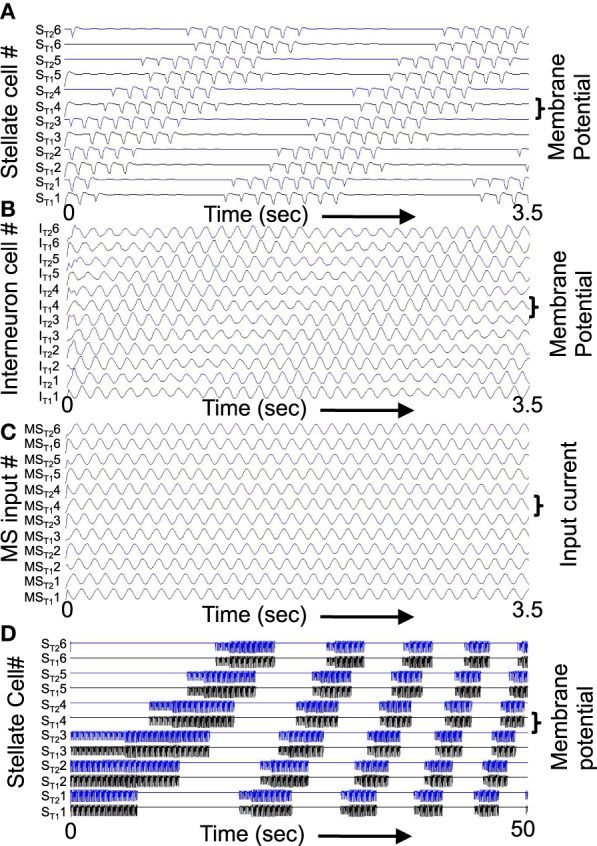
Example of shift in population activity driven by timing of rebound from inhibition using parameters gp = −0.75, gh = 0.15, m = −1, and oh = −0.35 from Figure 1. (A) Activity of G/S neurons from ST11 and ST21 through ST16 and ST26 showing inhibitory effects of interneurons on G/S neurons visible as strong hyperpolarizing deflections. The G/S neurons with these parameters have resonance frequency of 10.2 Hz and show rebound that is slightly faster than the frequency of MS input (9.75 Hz) to interneurons. (B) Activity of interneurons (Int) from IT11 and IT21 through IT16 and IT26. The interneurons receive input from the G/S cells. Because the G/S cells have rebound that is slightly faster than the frequency of oscillatory MS input, the individual interneurons show a progressive shift between large amplitude oscillations when G/S input phase matches their current MS input, and periods of low amplitude when G/S input does not match their current MS input. (C) Oscillatory input from medial septum (MS input) showing the difference in phase of the MS input oscillations. Note that the higher indices have earlier phases (earlier peaks) than the lower indices. For example, MST12 peaks at an earlier time than MST11. (D) This network with resonance of 10.2 Hz can shift across a wide range of speeds by decreasing the medial septum frequency, which starts here at 10 Hz for stationary activity at t = 0 and decreases to 9.96 Hz at 50 s.